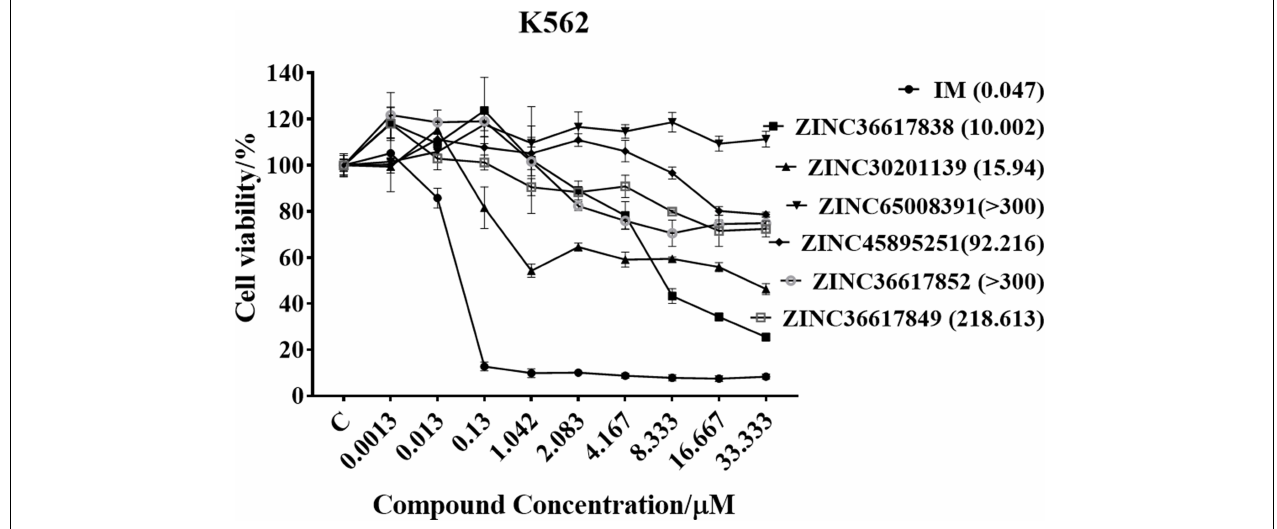
FIGURE 6 | Cytotoxic efficacy of compounds in K562 leukemia cells. Cells were incubated with various concentrations of IM, ZINC36617838, ZINC30201139, ZINC65008391, ZINC45895251, ZINC36617852, or ZINC36617849 for 72 h. Cell viability was determined using the MTT assay. The results are represented as the mean ±